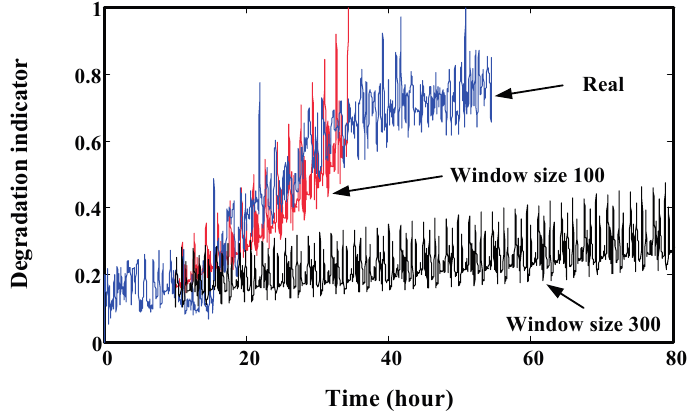
Figure 6. Prediction results comparison using different window sizes (start at 10 h).